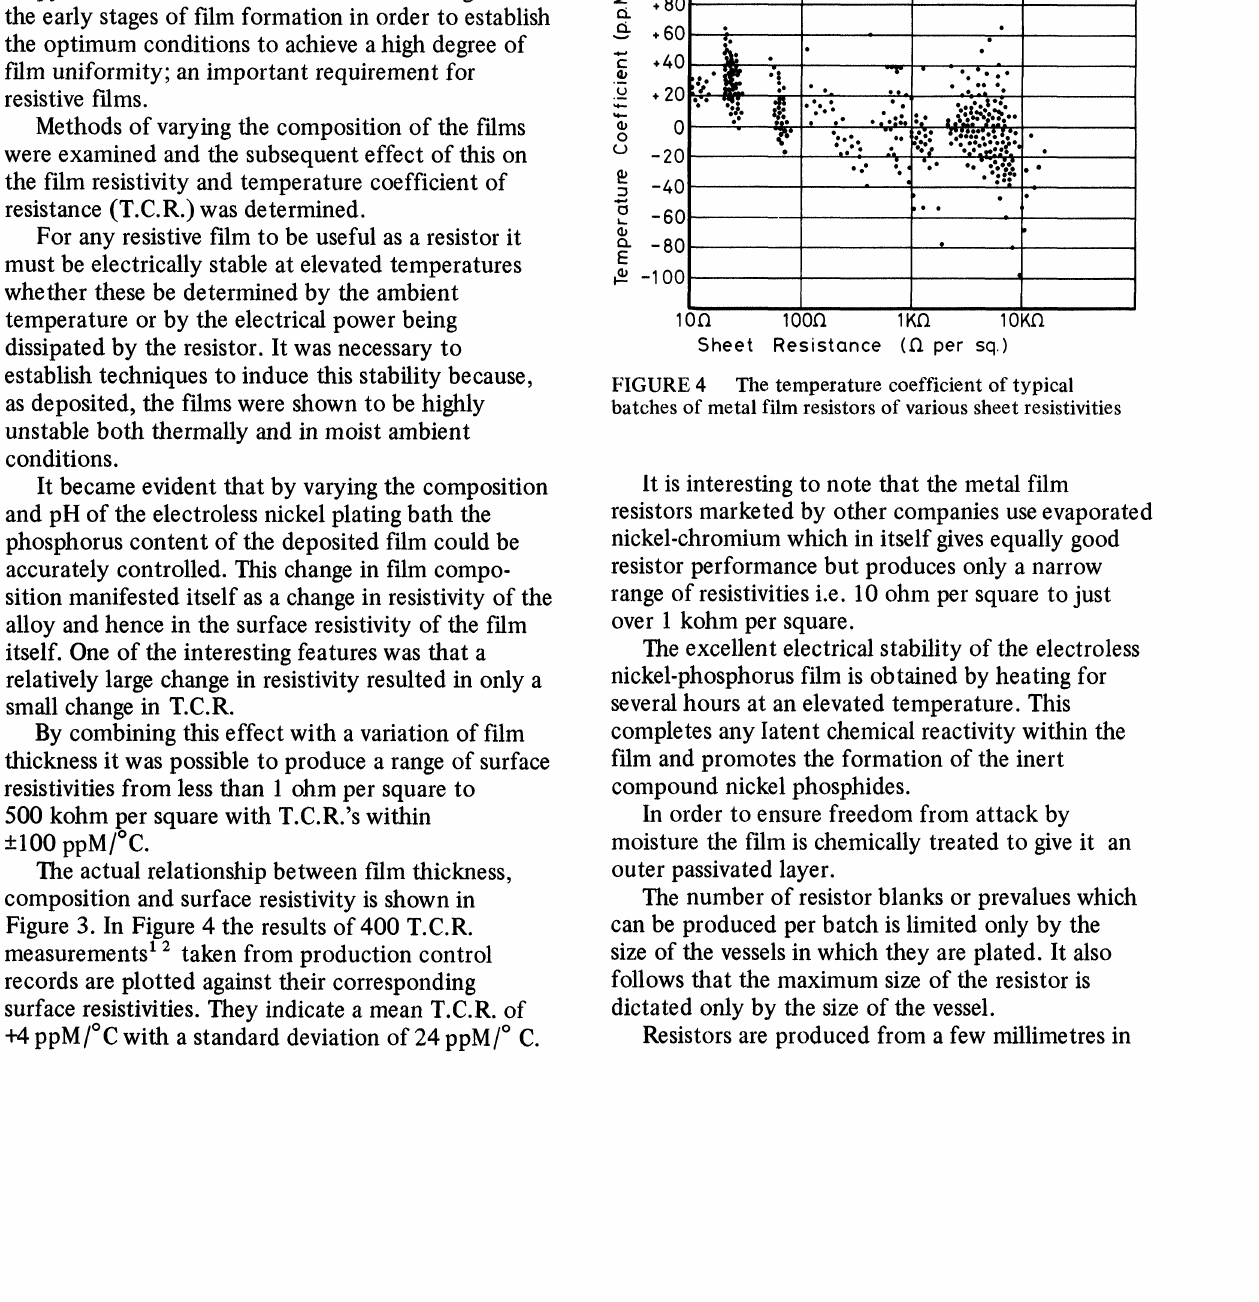
Relationship between film thickness, composition and surface resistivity for electroless nickel- phosphorus films